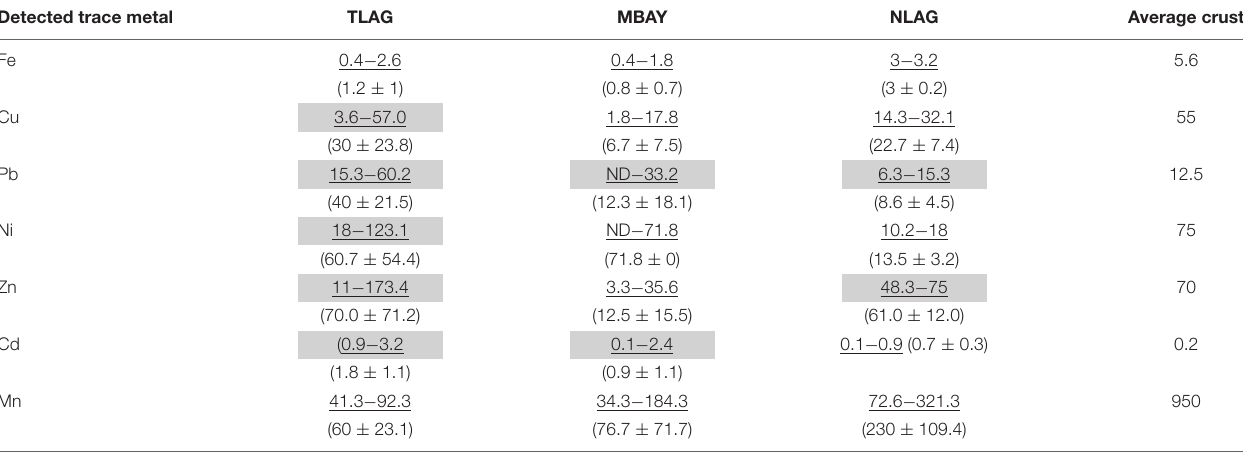
TABLE 2 | Concentrations of trace metals in sediments (mg • kg − 1 db) except Fe (%). Detected trace